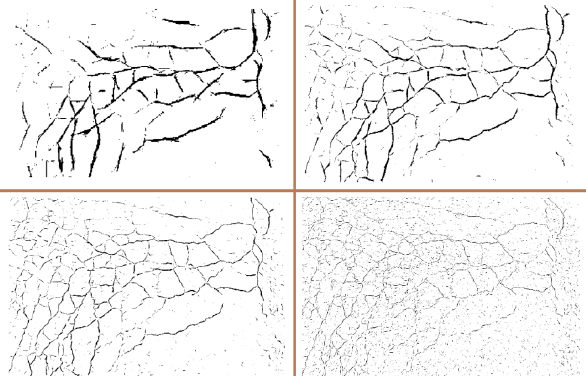
Figure 4. Detected crack pixels on 8 mm (top left), 4 mm (top right), 2 mm (lower left) and 1 mm (lower right) resolution The detected crack pixels on level 4 (coarsest level) looks quite proper but on the other hand not all cracks (in particular the narrow cracks) have been detected. Potential detected crack pixels on level 1 (finest level) are quite noisy. The main reason of the noisiness in level 1 is that all tiny borders between asphalt and aggregates have been detected as potential crack